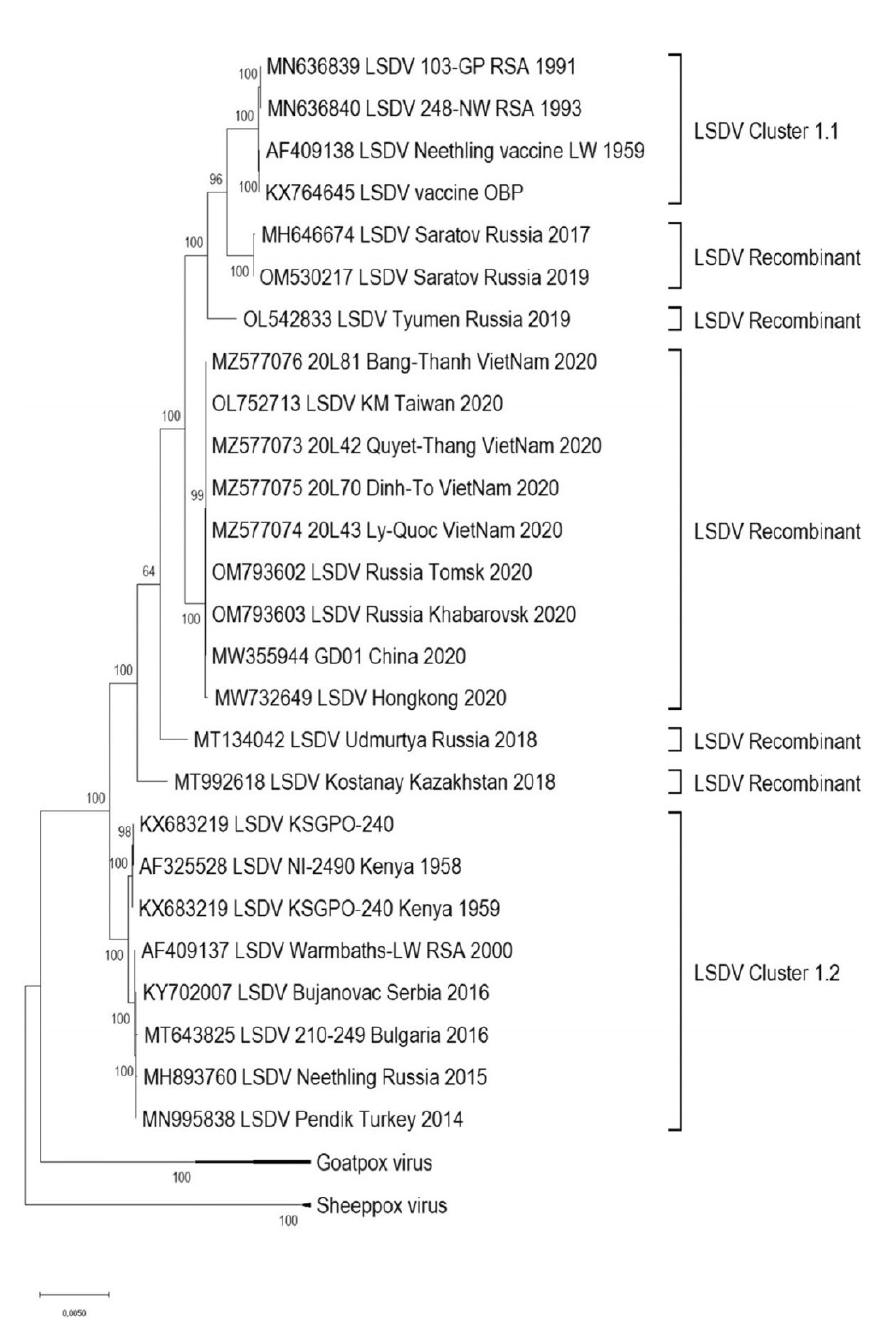
Figure 4. Maximum likelihood phylogenetic tree representing genetic relationship of the complete genome sequences of 26 LSDVs, 2 GPVs and 2 SPPVs with permission from A. Sprygin [78].